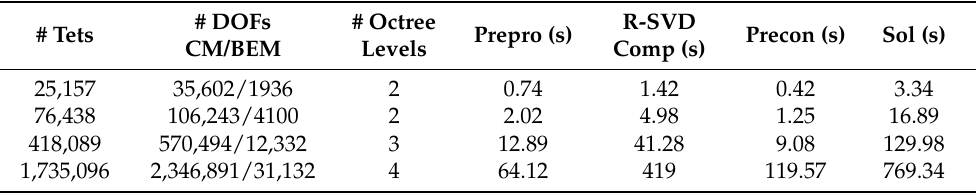
Table 2. Computation times for the CM-BEM software with R-SVD compression (prepro: